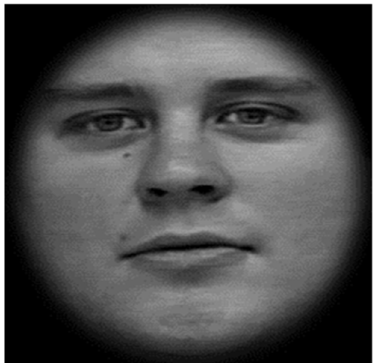
Figure 1. Example of a frame of a human face without distracting elements (adapted from Fantamorph). ©Jeffrey Cohn, S52.